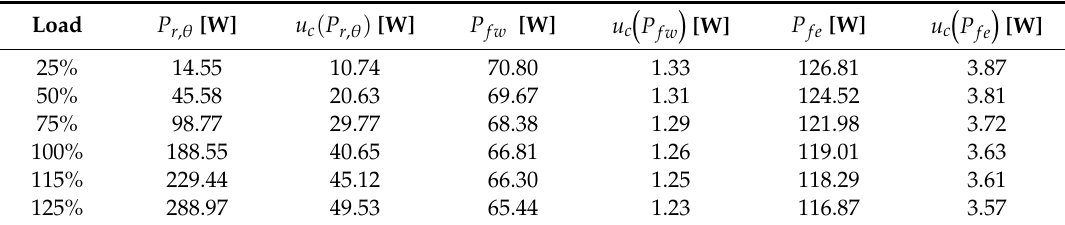
Table 2. Experimental results: rotor winding losses, friction and windage losses, and iron losses with uncertainties.